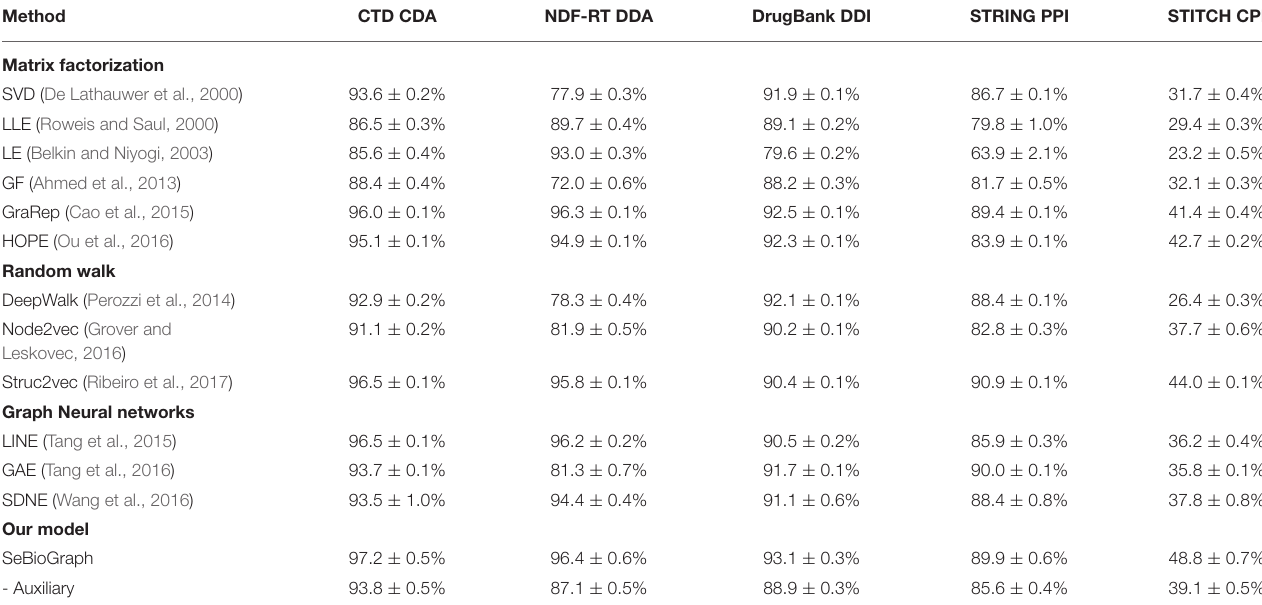
TABLE 3 | Comparison of accuracy value between SeBioGraph and other link prediction methods on five biomedical graph datasets.